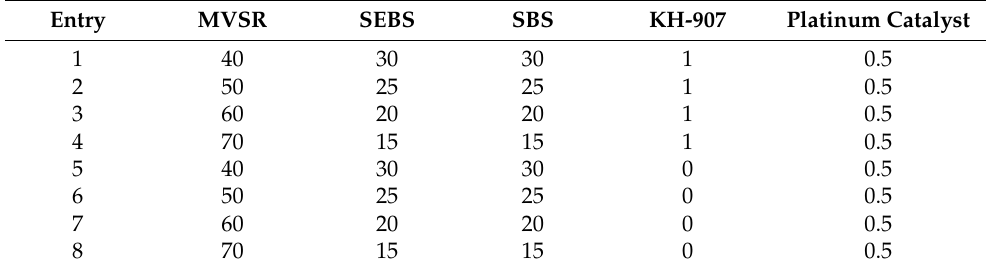
Table 1. TPSiV dynamic vulcanization experimental formula (unit: phr) (a)